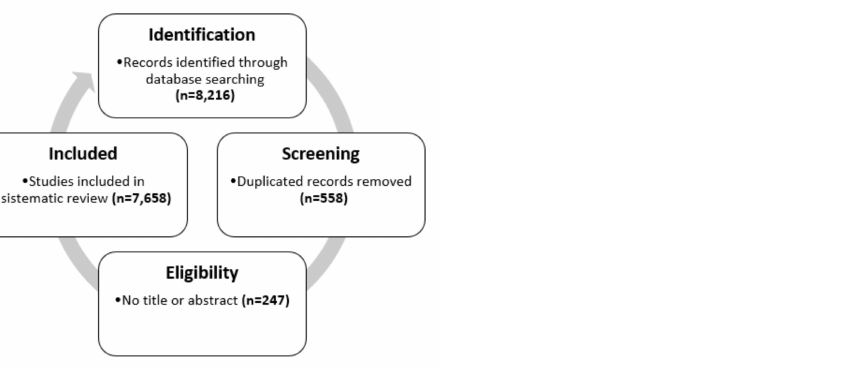
Figure 3. Gathering, filtering, and selection the articles for studies on neuroendocrine tumors.